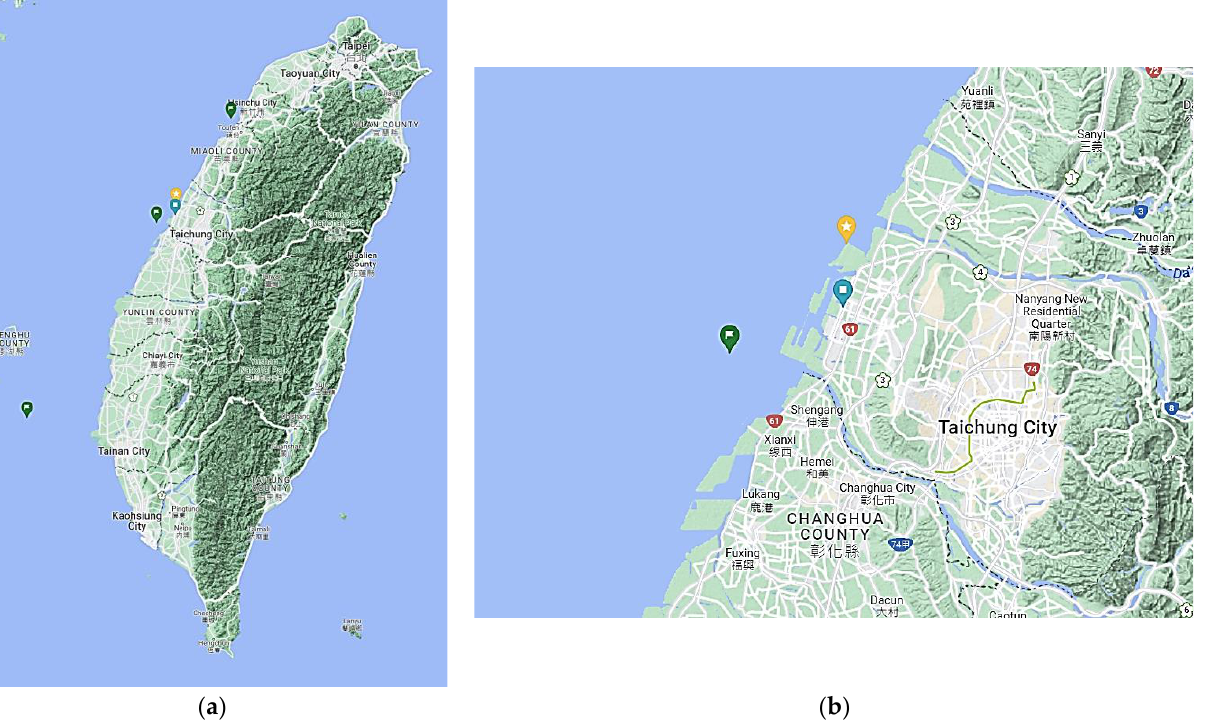
Figure 3. ( a )The position of the buoys, Wuqi station, and met mast. The green tags from north to south are the Hsin Chu, Tai Chung, and Ci Mei buoys, respectively. The blue tag is Wuqi Station, and the yellow tag is the BSMI met mast. ( b ) Surface observation sites around central Taiwan.